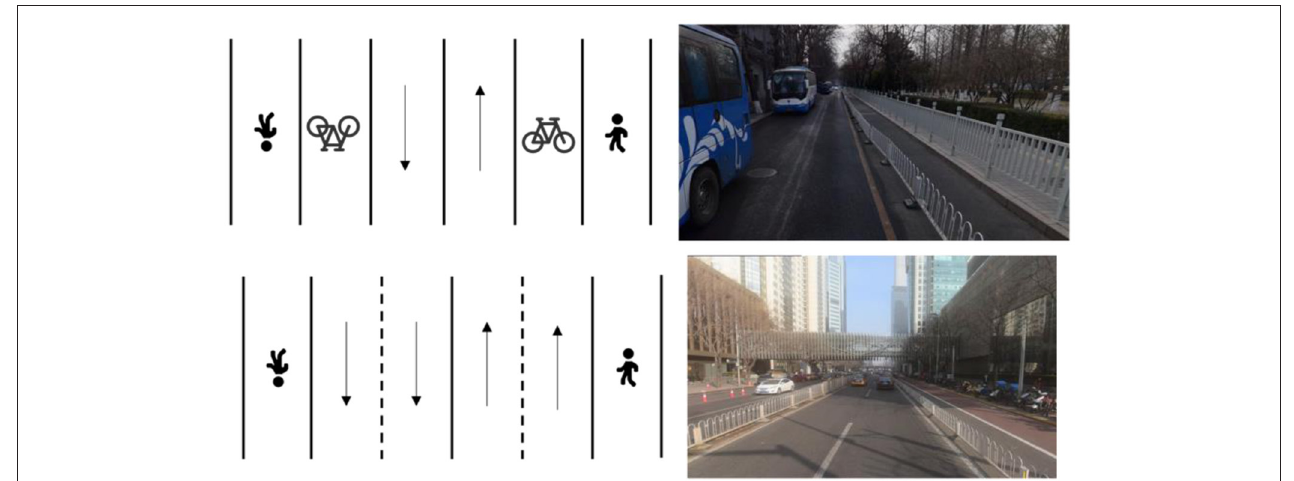
FIGURE 5 | Structure of general